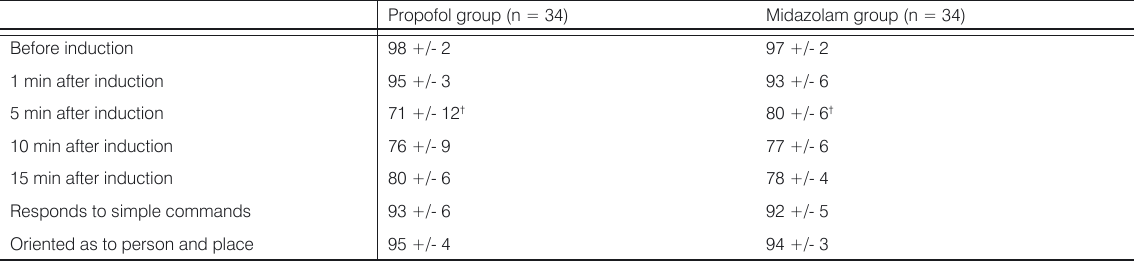
Table 3. BIS values in the two groups*.